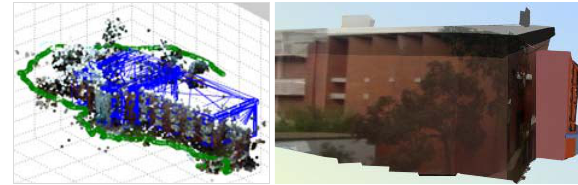
Figure 4. Test area “Curtin University”. Left: Calculated camera position (green), 3D mode (blue) and generated point cloud (true colors). Right: manually texture 3D